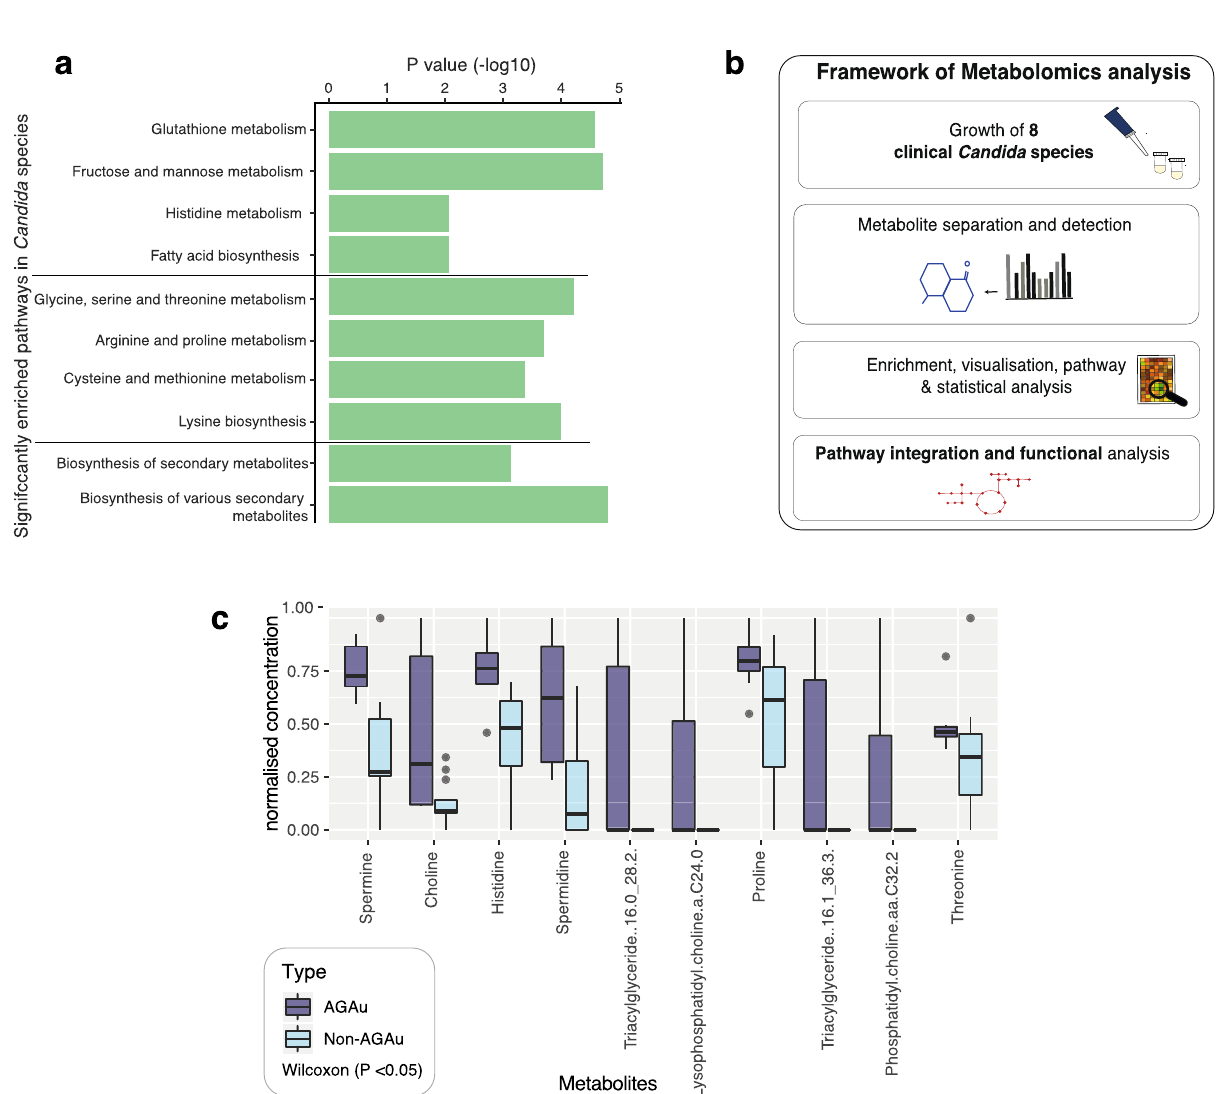
Fig. 3 Comparison of functional and metabolomics in AGAu and non-AGAu strains. a Pathway enrichment in 49 Candida strains . Signi fi cant metabolic pathways highlighted in Candida species indicating genetic pathway potential (Hypergeometric tests on contrasted annotation between AGAu and non- AGAu species, p values < 0.05). b Framework outline of metabolomic analysis of Candida species ’ metabolism levels of bioactive metabolites in Candida strains exhausted media . Computer simulations were performed for pathway analysis, and statistical approach was applied for candidate metabolites that have a potential in fl uence on the host. c Enriched metabolites detected in targeted metabolomics between AGAu and non- AGAu groups (Wilcoxon rank-sum tests, P values < 0.05, middle line for median with interquartile range (IQR) and whiskers 1.5× IQR, “ Method ”